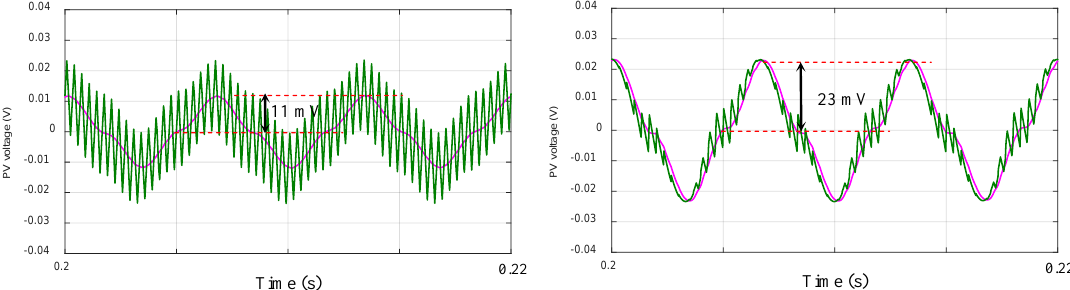
Figure 4. Alternating PV voltage ripple (green trace) and its averaged value over the switching period (pink trace), for m = 0.577/2 (left) and m = 0.577 (right), I ac / wC = 1.